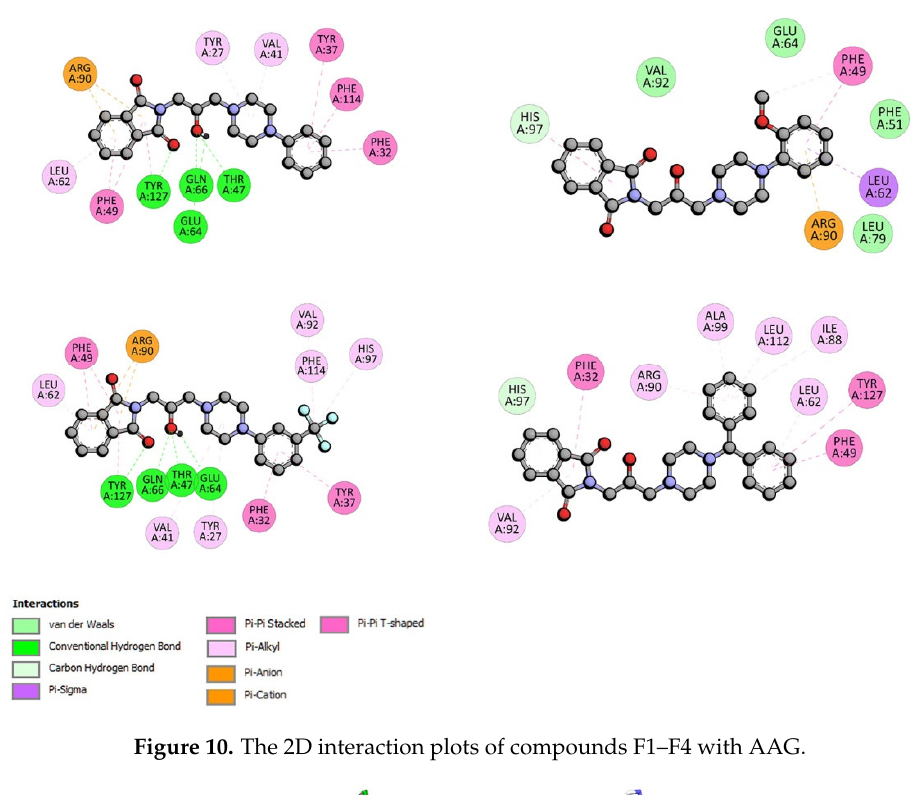
Figure 9. Docked pose and interactions of compound F4 with AAG.